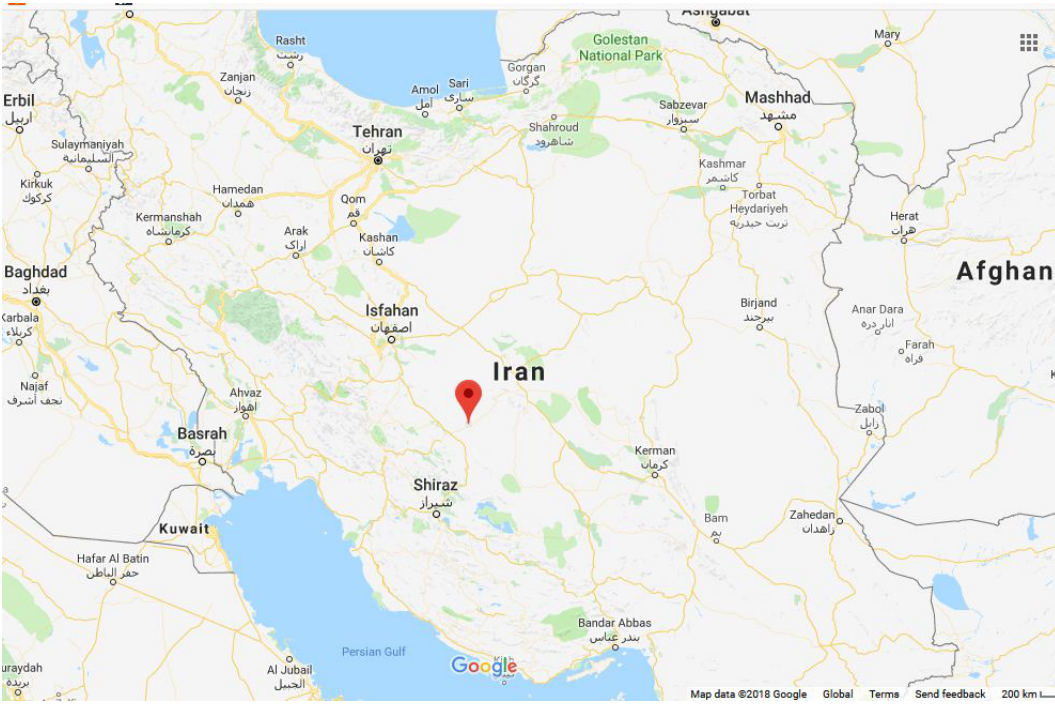
Figure 3. The location of Abarkooh city [22].